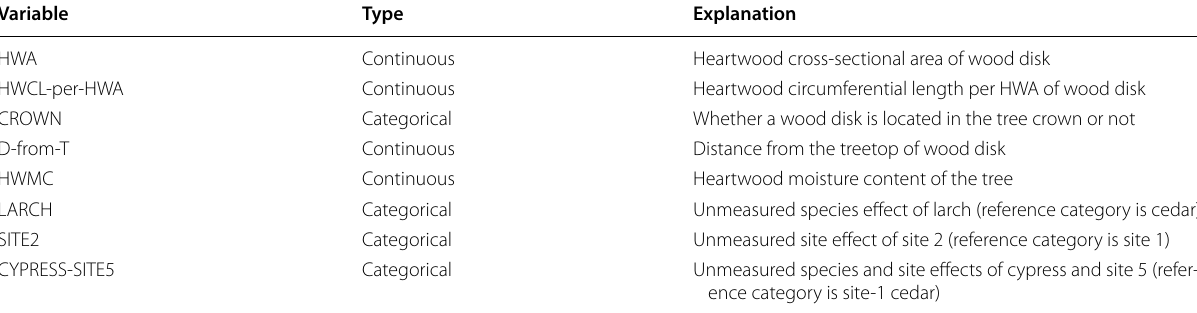
SW sapwood, HW heartwood